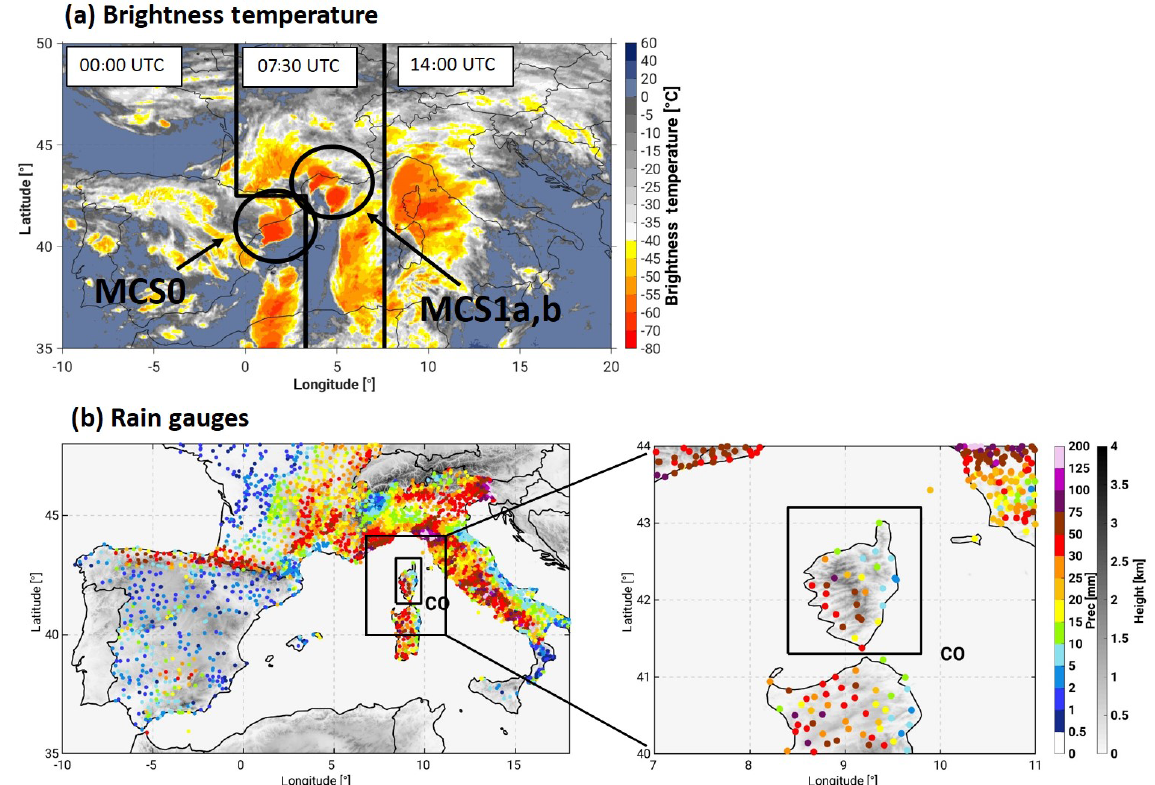
Figure 3. Composite image of brightness temperature as measured by the SEVIRI instrument on 26 October 2012 at 00:00UTC, at 07:30UTC and at 14:00UTC (a) . Rain-gauge-accumulated precipitation over the complete WMed region between 26 October at 13:00UTC and 27 October at 15:00UTC and a close-up of the study region of Corsica (b) . The accumulation period shown is the period of heavy precipitation over our main study region, the island of Corsica (black box), during this